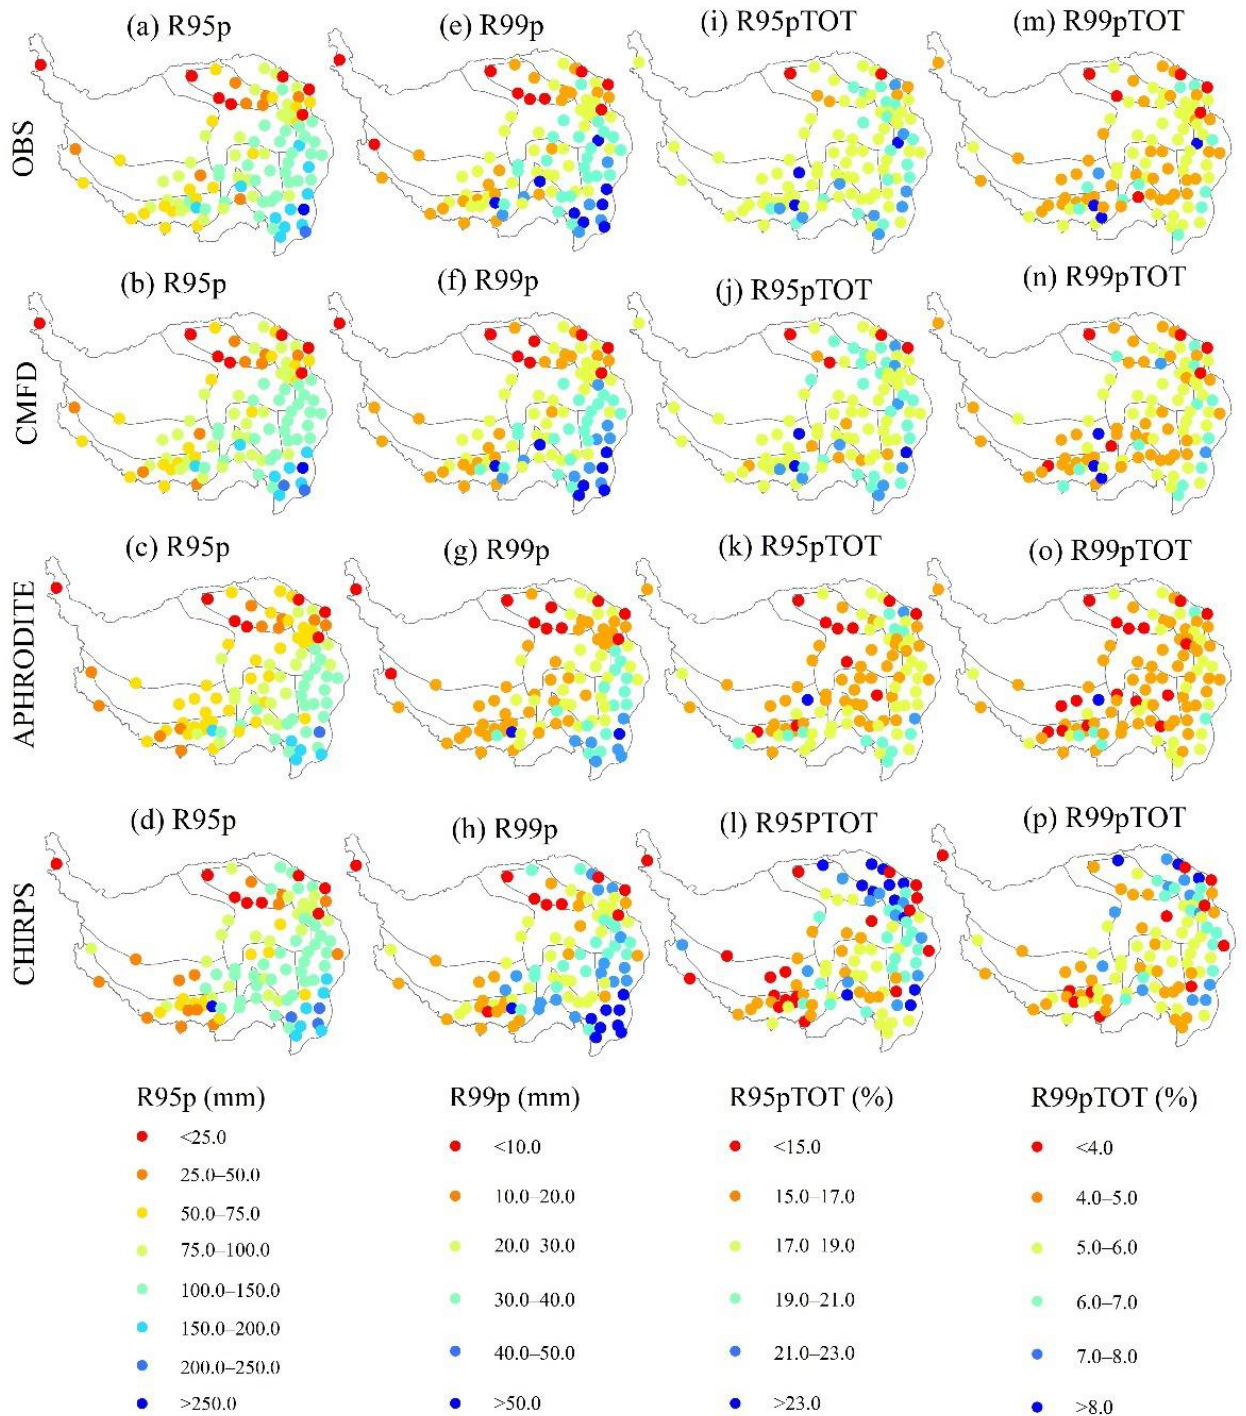
Figure 8. Mean spatial distribution of station-related threshold indices from 1981 to 2014: R95p, R99p, R95pTOT, and R99pTOT.